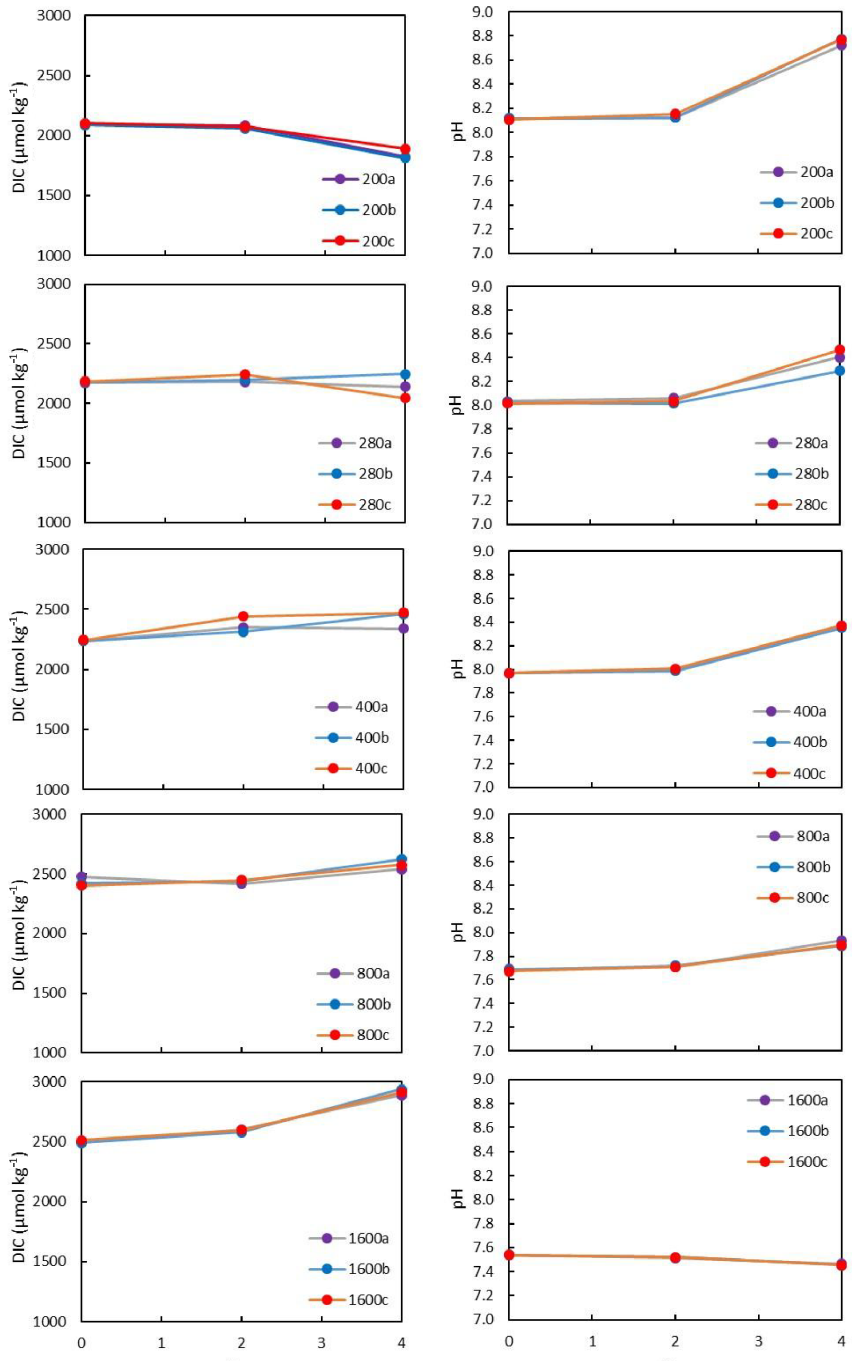
Figure 2. Each culture treatment labelled according to target p CO 2 and showing the evolution in the culture media through the experiment. All treatments exhibit changes in DIC due to diatom growth balanced with the input of CO 2 . The higher p CO 2 , the more DIC increases towards the end of the